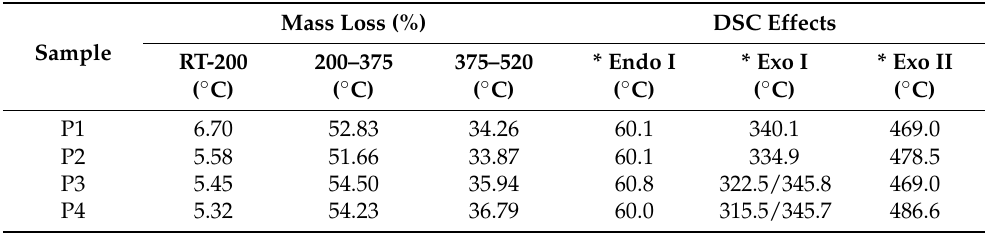
Figure 5. Thermogravimetric analysis (TG and DSC) of the studied samples: ( a ) P1 and P2 and ( b ) P3 and P4. Table 2. Centralized data from thermogravimetric curves of the studied